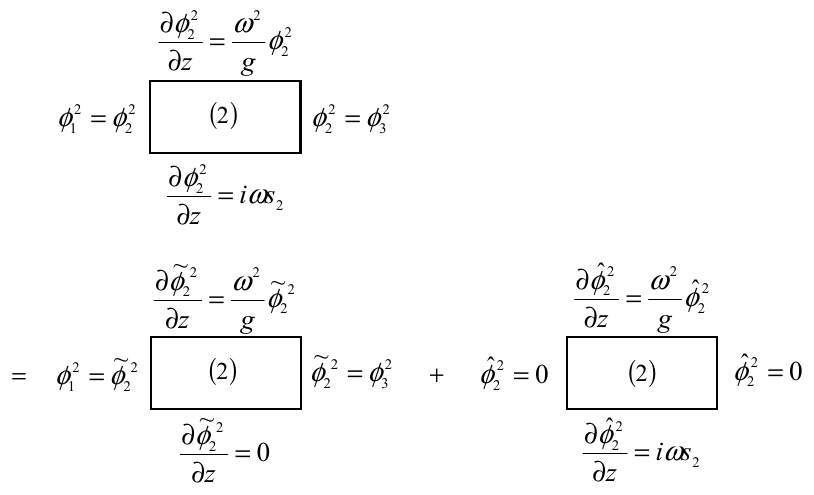
Figure 2. Decomposition of nonhomogeneous boundary conditions.